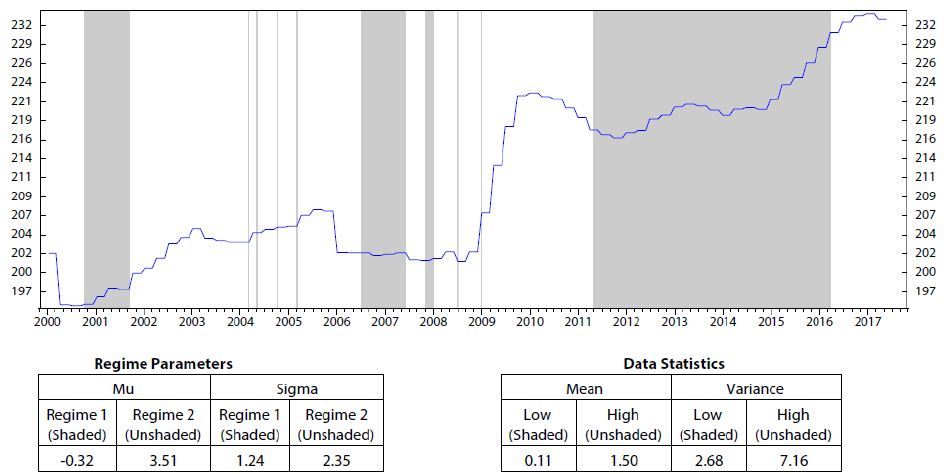
Figure A5. The world debt and its regimes detected using HMM for monthly data from 31 December 1999 to 31 August 2017. Regime 1 and regime 2 represent the low and high periods of the world debt, respectively.